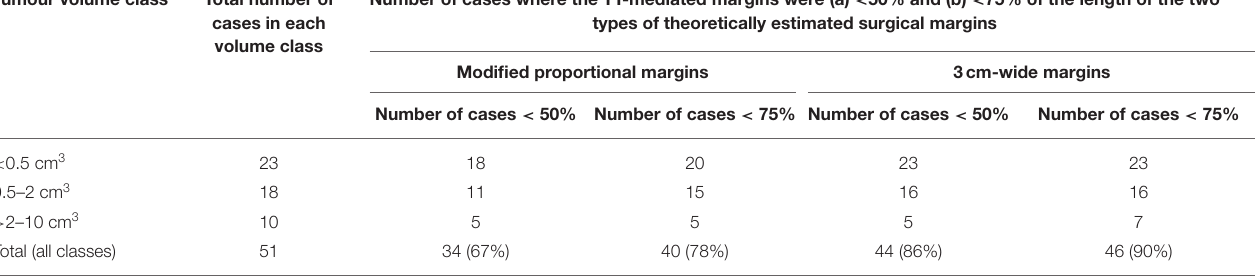
TABLE 2 | Comparison by tumour volume class of number of cases in which the TT-mediated margins were (a) < 50% and (b) < 75% of the length of the theoretical values calculated for the modified proportional and the wide 3cm surgical margins.